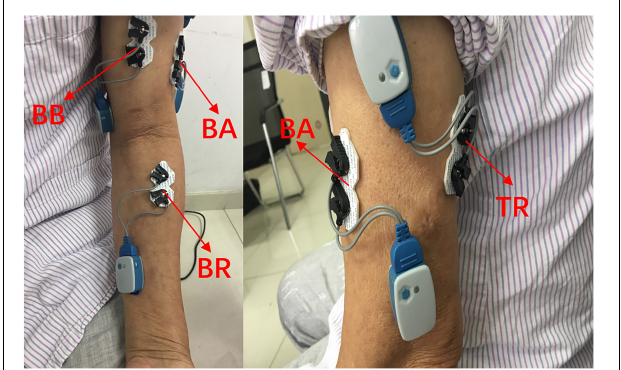
TABLE 1 | Details of the 11 stroke subjects.